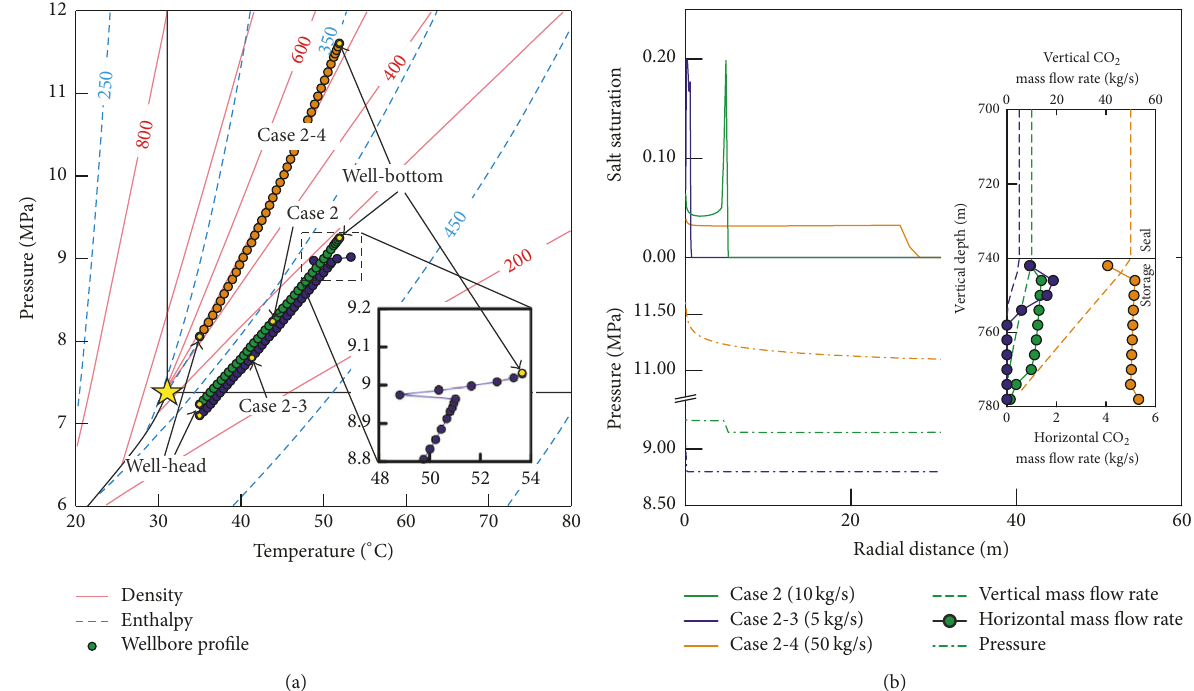
Figure 8: (a) Changes of CO 2 properties (density [kg/m 3 ] and enthalpy [kJ/kg]) within the wellbore and (b) development of salt saturation [-] and built-up pressure [MPa] at the bottom layer. The small panel represents both horizontal and vertical CO 2 mass flow rate [kg/s] within the wellbore at three different injection rates (5, 10, and 50 kg/s) after 1,095